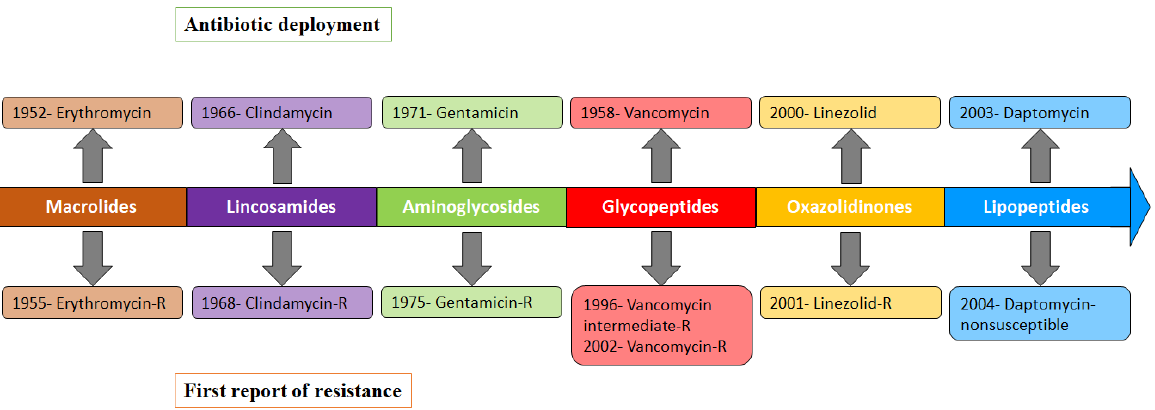
Figure 1. Timeline of the key non- β -lactam antibiotics deployment and the first reported cases of S. aureus resistance identified. S. aureus resistance